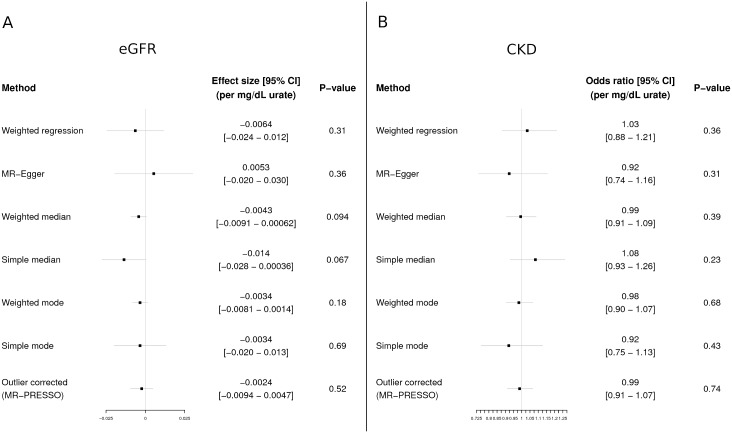
MR analysis of the effect of SU on eGFR and CKD.Estimates of causal effects of serum urate on eGFR (A) and CKD (B) by 7 MR analyses. Effects are shown per 1-mg/dl increase of serum urate. The effect sizes/odds ratios and P values were calculated using all single nucleotide variants (SNVs), except for the outlier-corrected MR, where pleiotropic SNVs (detected by MR-PRESSO) were excluded. In the outlier-corrected analysis, 11 outliers were removed for eGFR and 4 outliers were removed for CKD (see S2 Table). CKD, chronic kidney disease; MR, Mendelian randomization; SNV, single nucleotide variant; SU, serum urate.